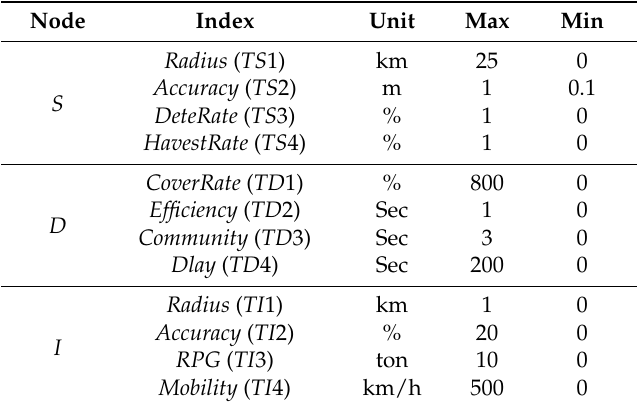
Table 4. The reference values of the tactical and technical indexes.